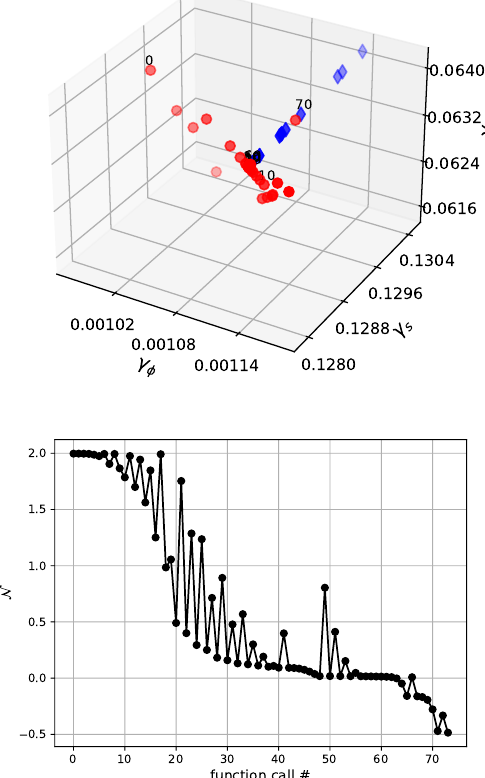
Figure 15: BFGS run for N = 2, d = 3.7 at Λ = 19 with the initial guess supplied by eq. (7). Red points are disallowed, blue diamonds are allowed. This run does converge to the